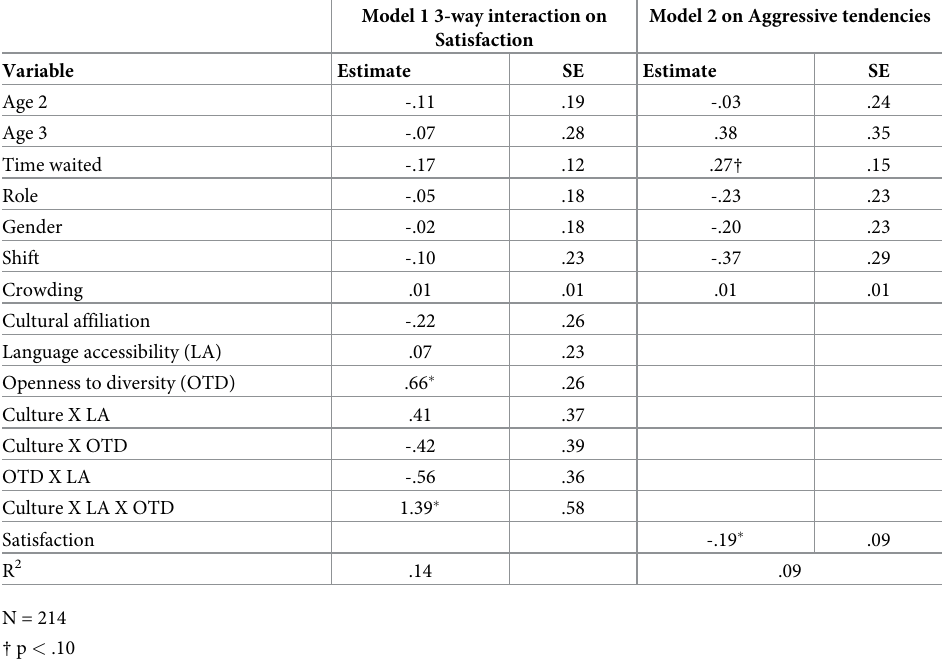
Table 3. Structural equation analysis for the research model.